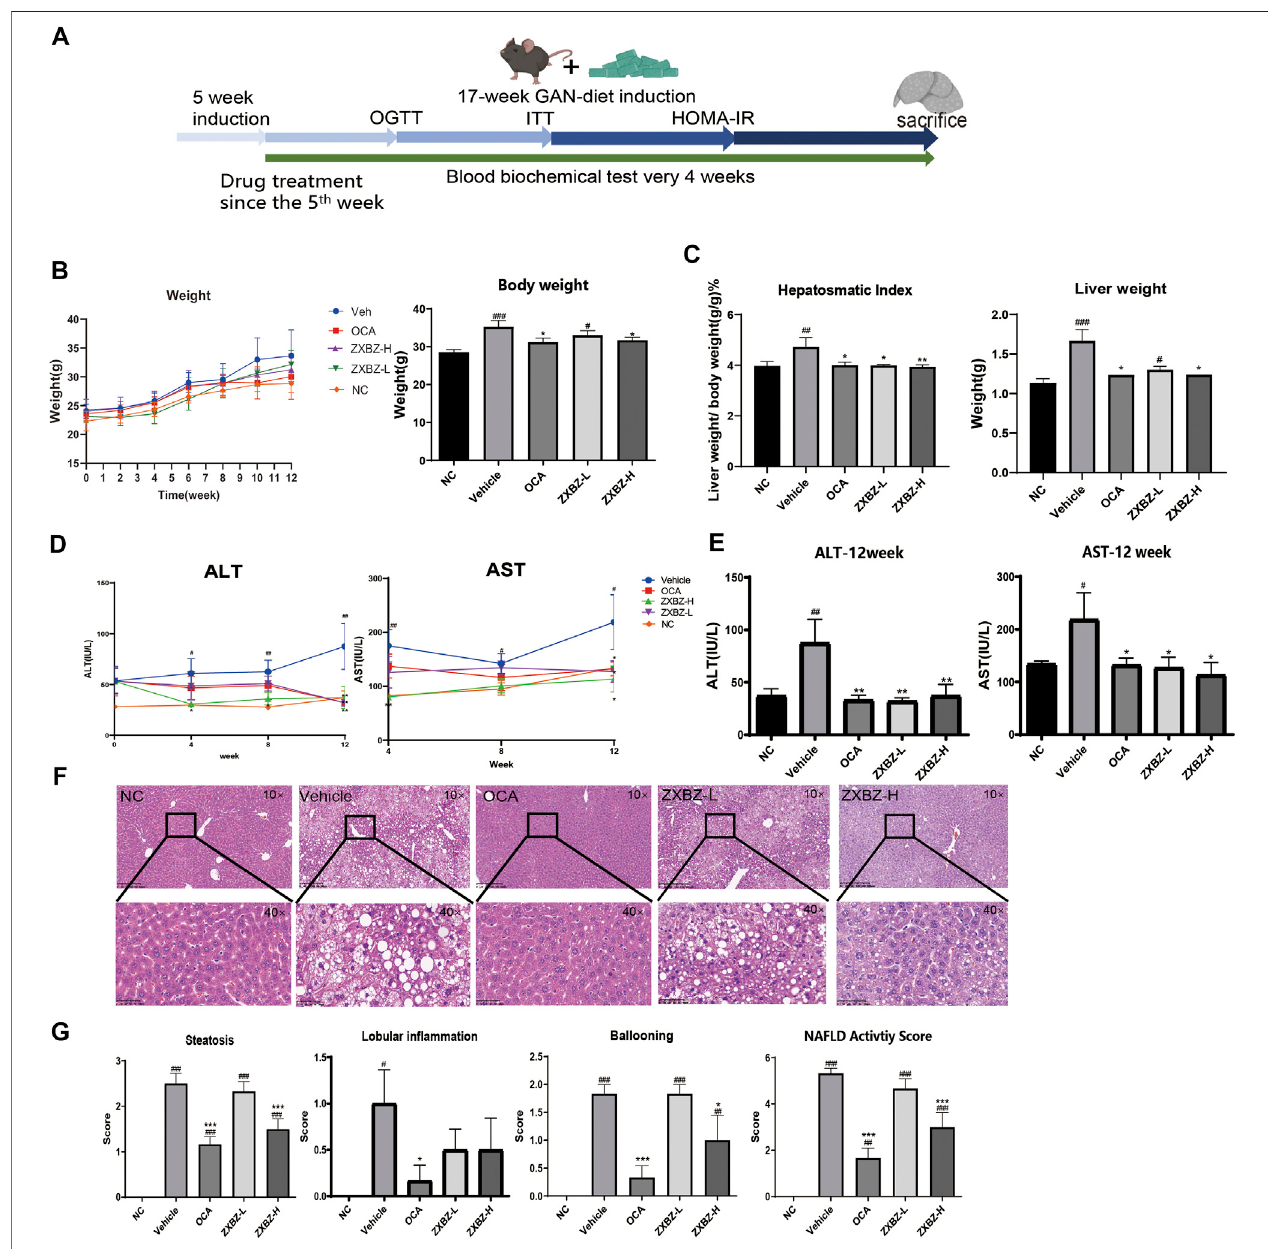
FIGURE2| LiverprotectiveeffectofZXBZdecoction. (A) Designandtimelineofanimalexperiments. (B) Bodyweightthroughoutthewholedrugtreatmentprocess and the end point body weight. (C) Hepatosomatic index and the liver weight. (D) ALT and AST in the drug treatment process. (E) End point ALT and AST. (F) H&E staining of each group (10× and 40×). (G) NAFLD activity score. The histological NAS scores of necroin fl ammatory, ballooning, and macrovesicular steatosis were determined by a certi fi ed pathologist. The data are the mean ± SEM ( n = 8 – 10 per group). # p < 0.05, ## p < 0.01, ### p < 0.001 compared to NC. * p < 0.05, ** p < 0.01, *** p < 0.001 compared to